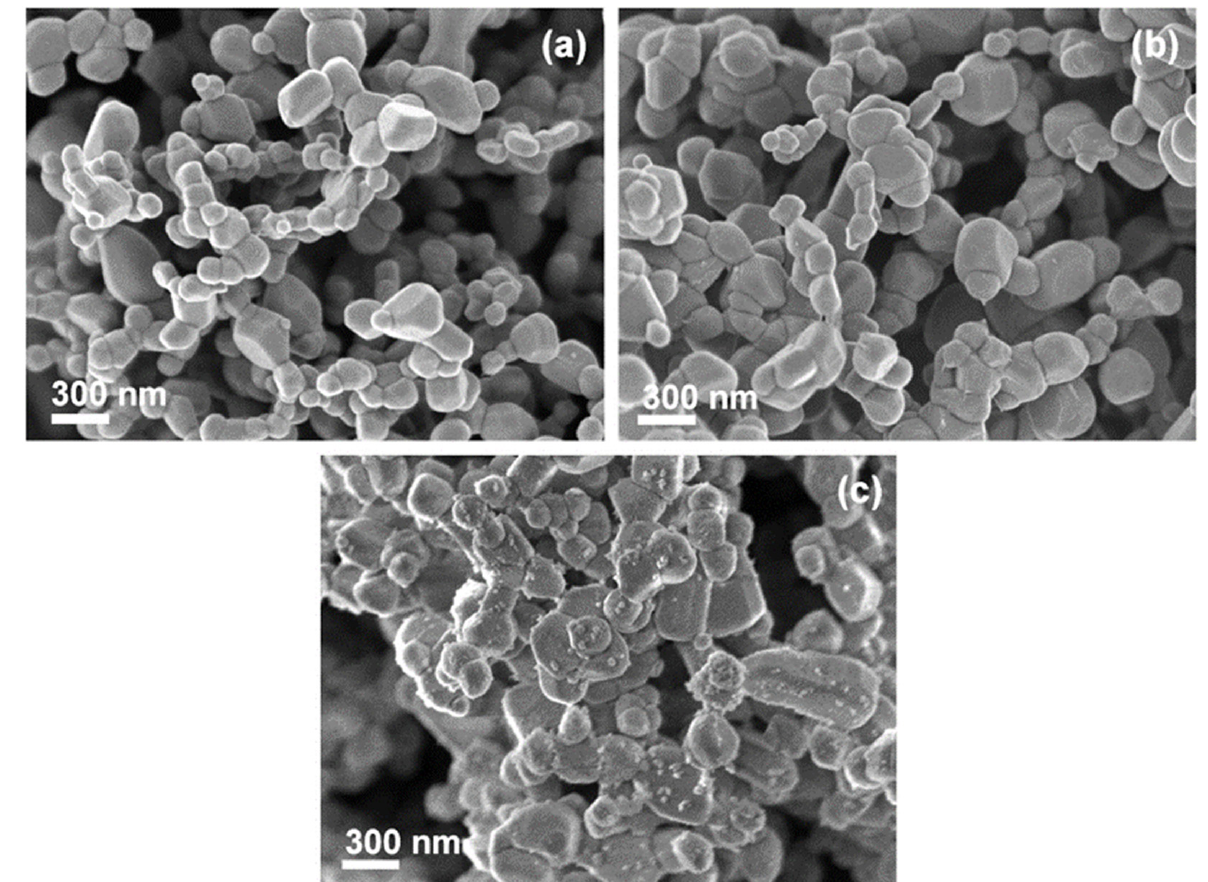
Figure 4. SEM images of pure ZnO ( a ), Ag/ZnO (I) ( b ), and Ag/ZnO (II) ( c ). To distinguish ZnO and Ag particles and to determine the Ag NP density distribution, the Ag-loaded ZnO samples were visualized with a back scattered electron (BSE) mode of SEM (BSE-SEM). First, the particles in bright contrast BSE-SEM images were identified as Ag NPs (Figures S1 and S2). A comparison of BSE-SEM images of both Ag/ZnO samples (Figure S3, see Supplementary Materials) revealed that: (i) the distribution of Ag NPs was denser in Ag/ZnO (II) and (ii) the Ag NPs in Ag/ZnO (I) were bigger (up to 300 nm) (Figure